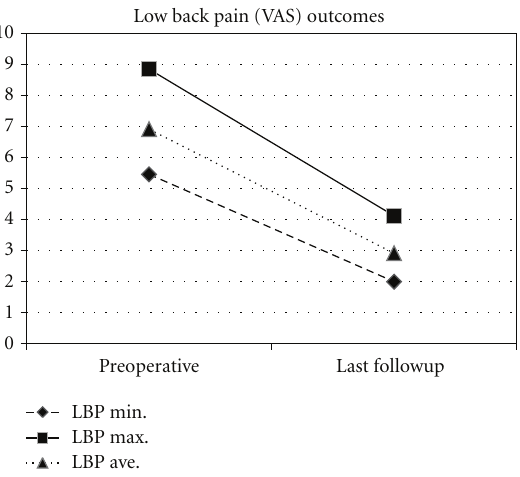
Figure 4: Change in average disability (ODI), and physical and mental quality of life (PCS and MCS) from preoperative to last followup (mean 11.5 months).